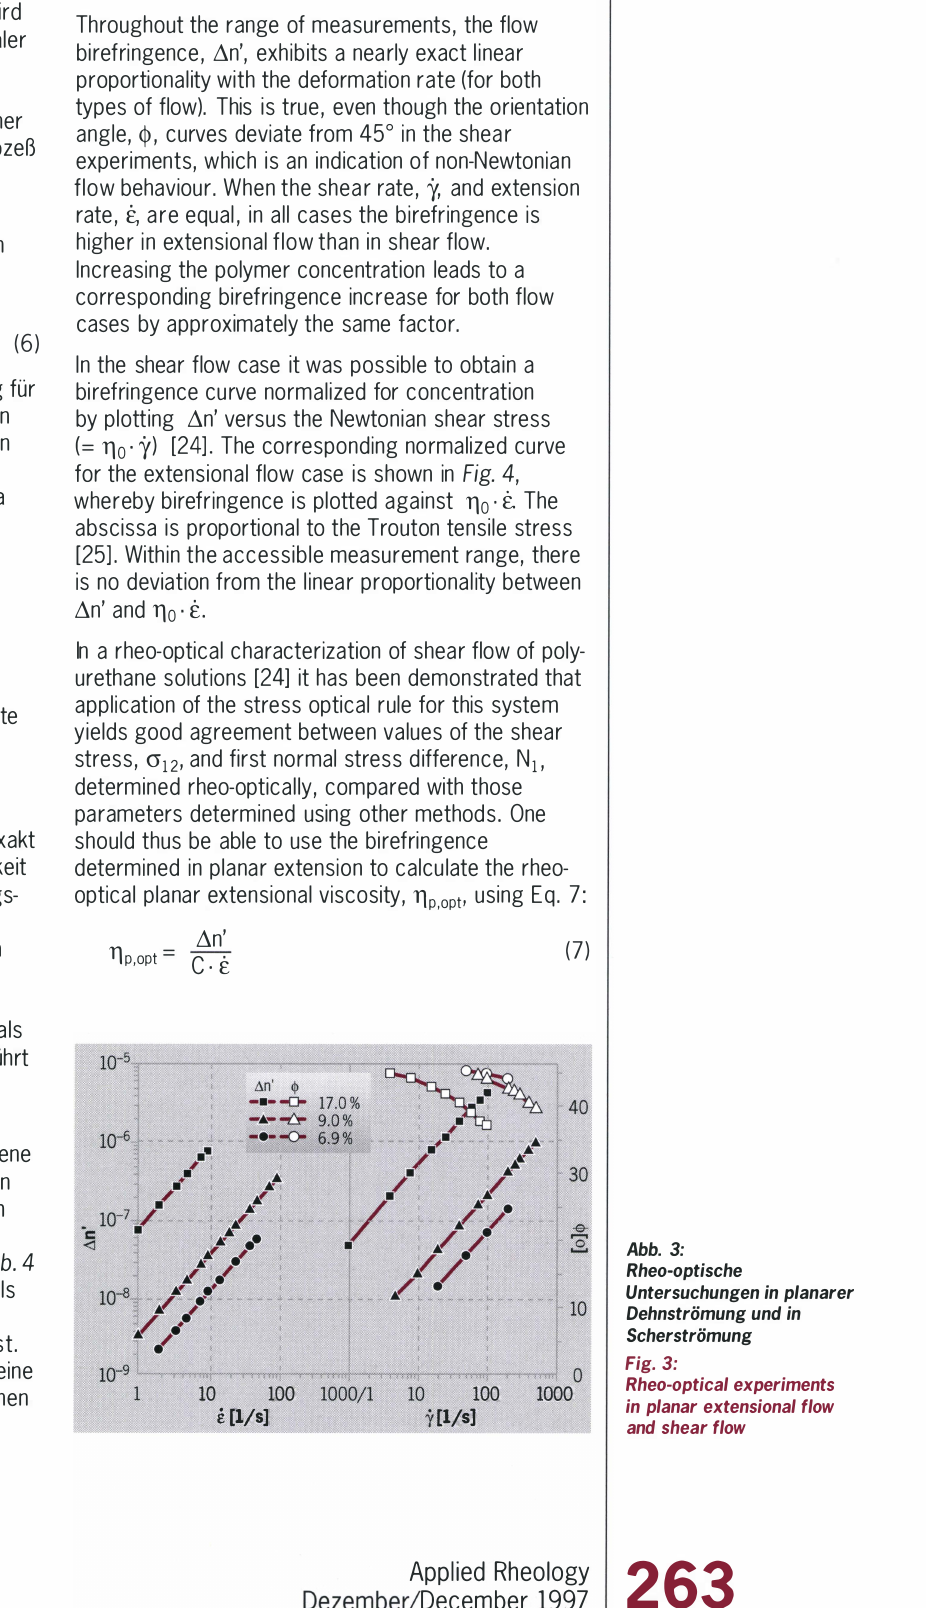
Applied Rheology